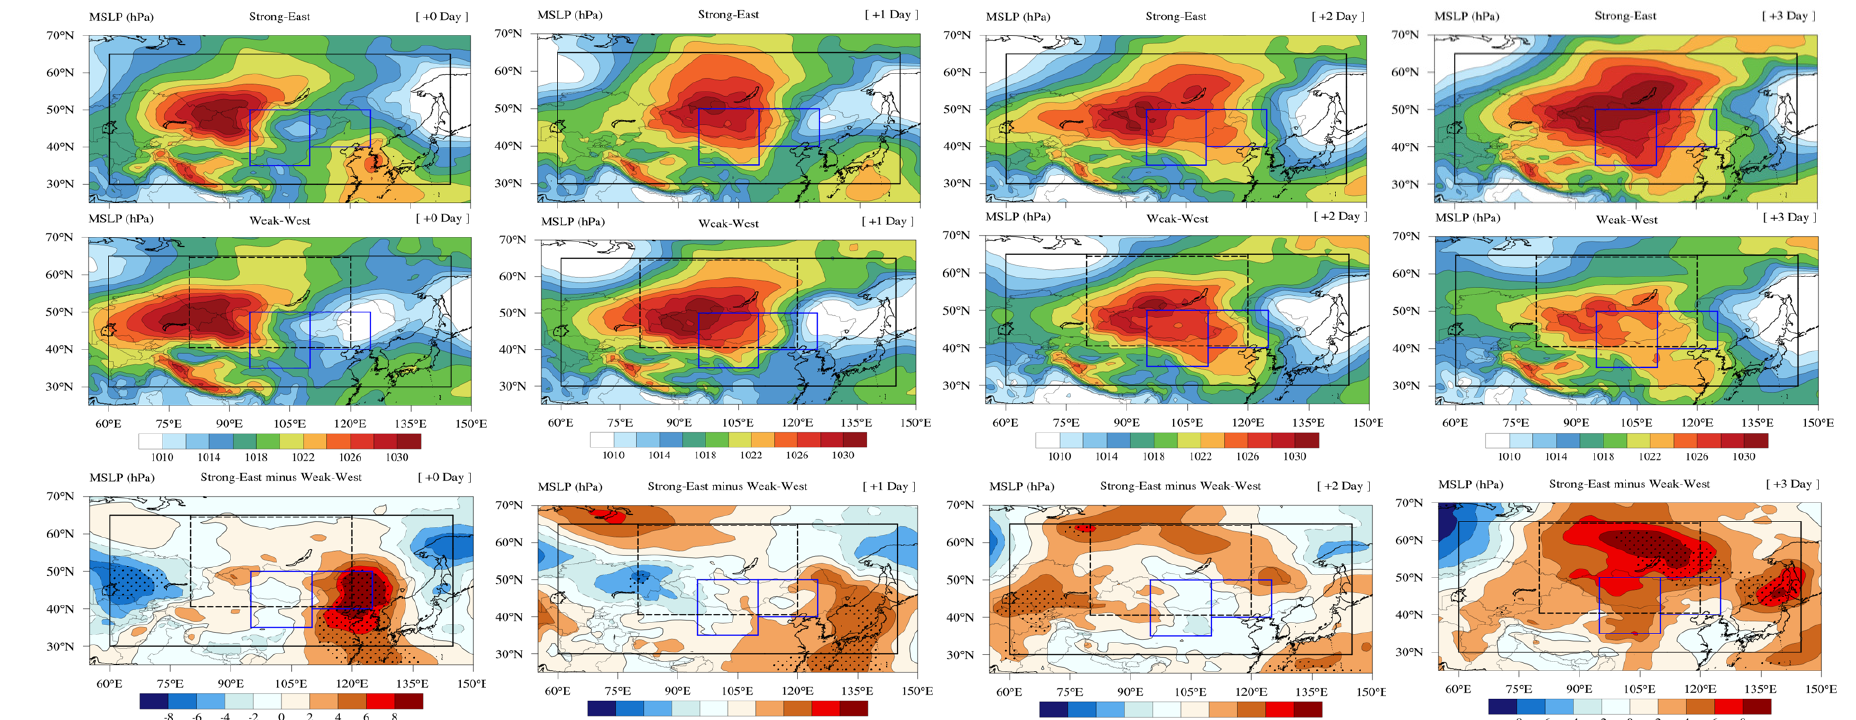
Figure 7. Four-day evolution of MSLP (hPa) averaged over 12 high-dust days for the Strong-East ( top panel ), Weak-West ( middle panel ), and difference between Strong-East and Weak-West periods ( bottom panel ). +0 Day is the day on which dust emitted in the merged region of R1 and R2. Black dotted areas indicate where the differences are statistically significant above the 90% confidence level based on the Student’s t -test.